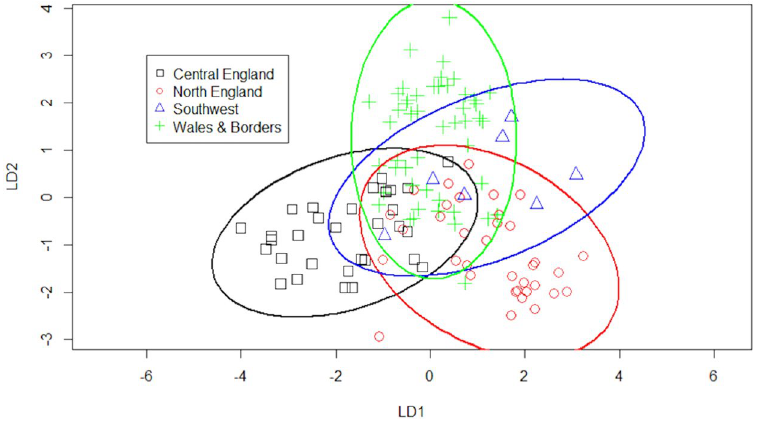
Figure 2. Partial discrimination between four genetically distinct sup-populations based on otter odour. Ordination plot of linear discriminants (LDs) 1 and 2 of the total otter VOCs. Ellipses represent the 95% confidence interval.